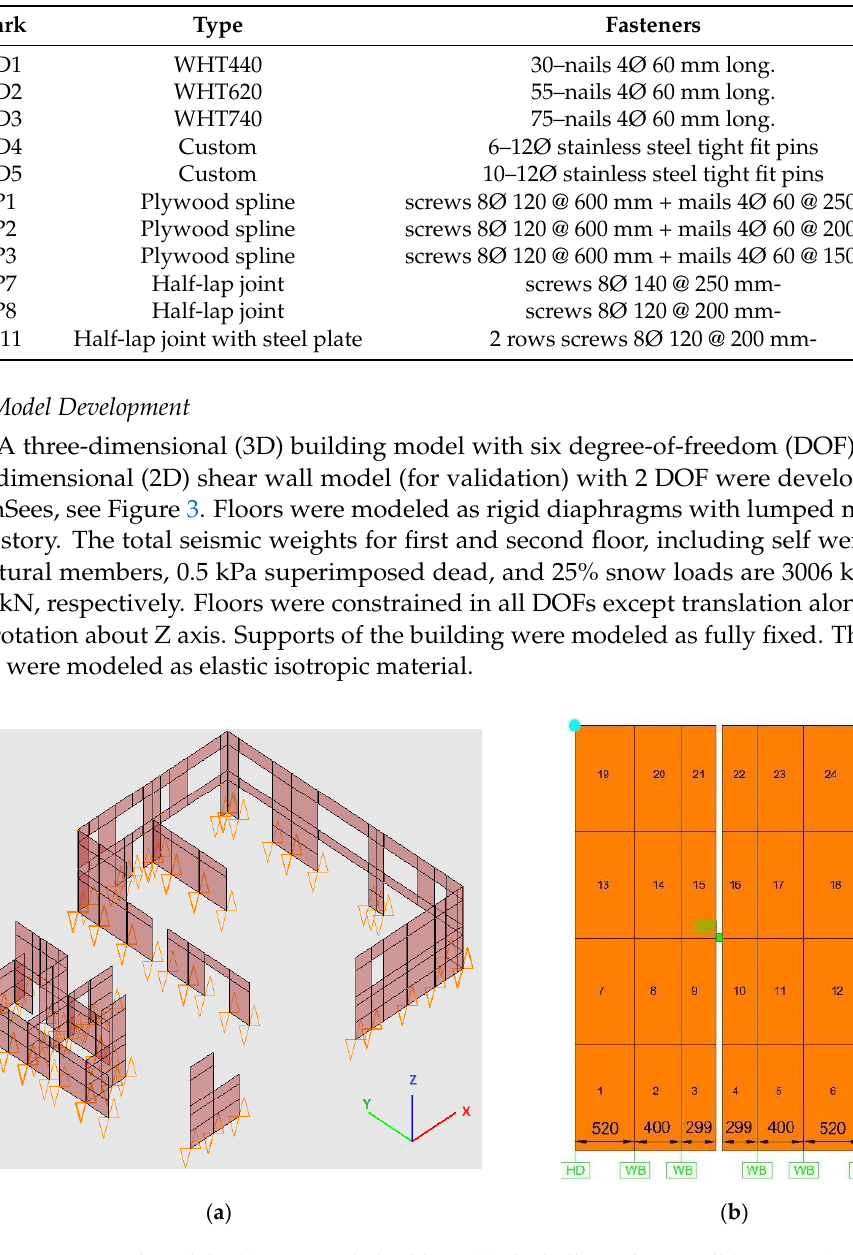
Figure 3. Numerical models: ( a ) case study building; ( b ) the balloon shear wall (unit: mm).